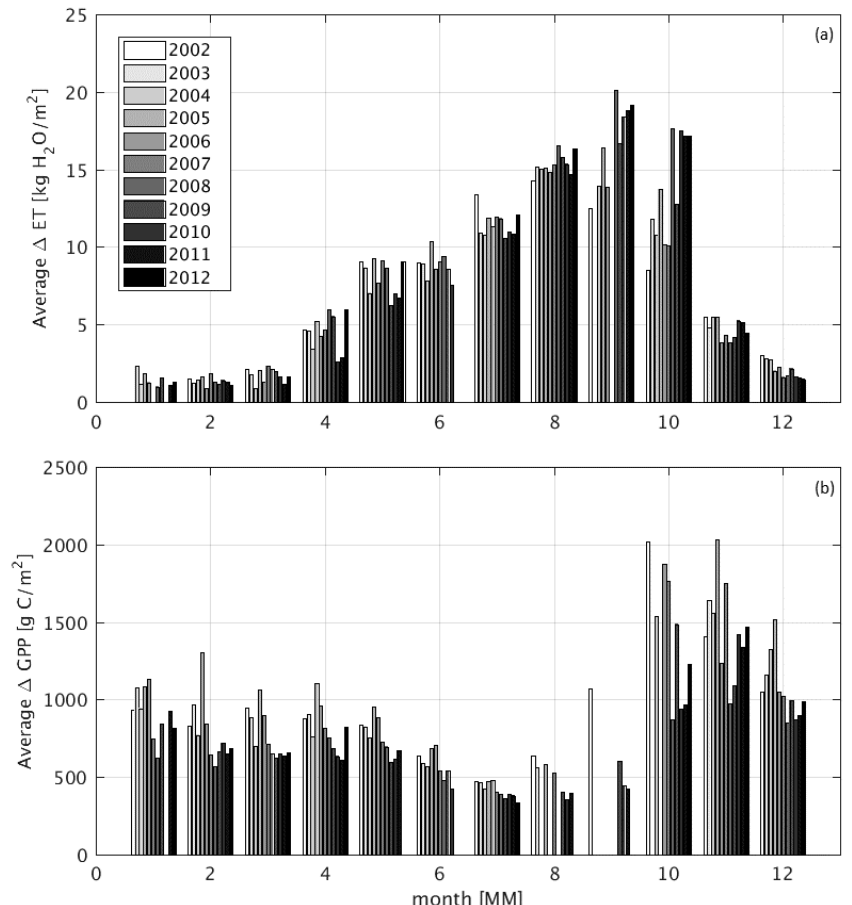
Figure 8. Bar plots of the monthly difference in ET ( a ) and GPP ( b ) for all wetland pixels over the study period 2002 to 2012. Δ = WET − DRY. Each bar is normalized by the area of wetlands present. Dry season differences in July correspond to about 50% of GPP at ZM-Mon. Note the inverse trends of ET and GPP in the wet–dry transition season (April–July) vis-à-vis the dry–wet transition